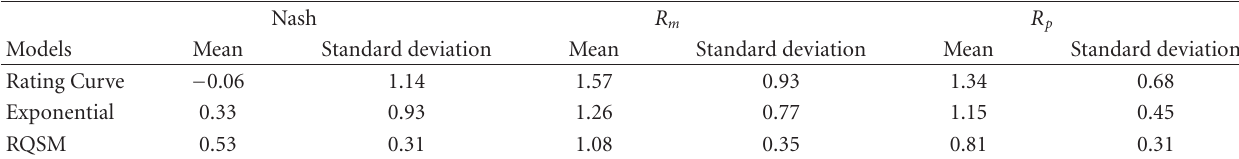
Table 5: Mean and standard deviation of the Nash, R P , and R M